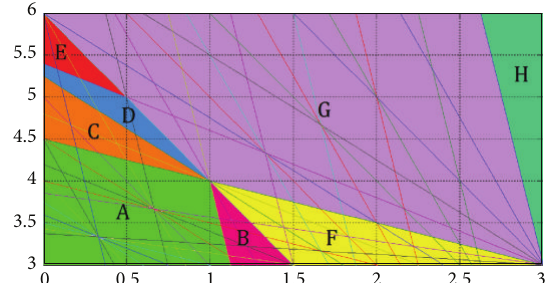
Figure 8: Partitioning of the 𝑃,𝑇 -plane according to the different patterns of spatial dynamics.